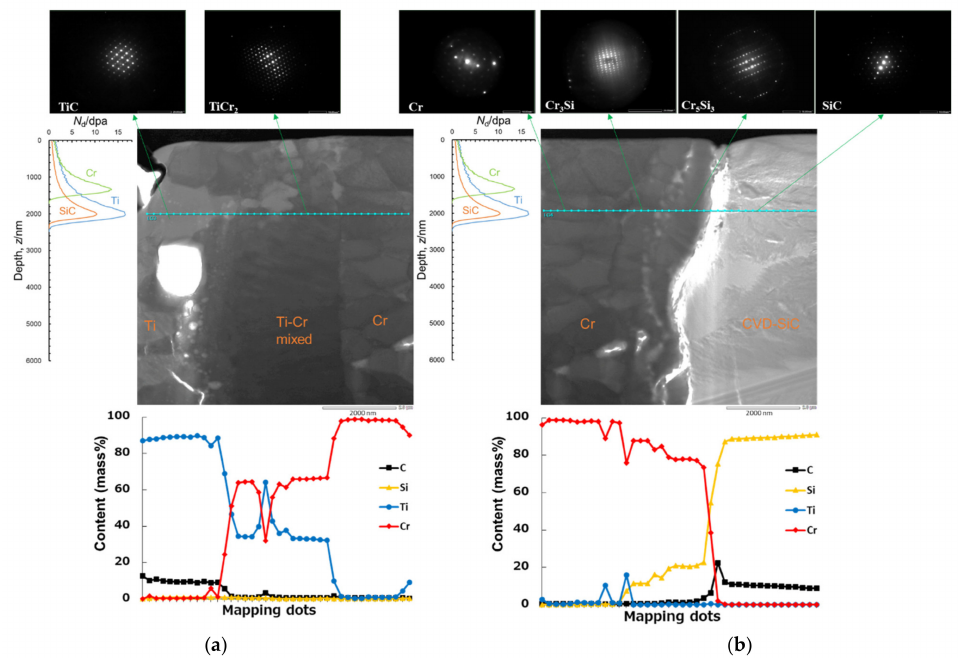
Figure 11. EDS line profiles of chemical composition and constituent phases along the analyzed line (bule-green) at the peak positions for the number of displacements per atom and constituent phases in Ti-Cr multilayer coating after being irradiated with Si 2+ ions up to a fluence of 2.85 × 10 20 ions /m 2 . The analyzed lines included ( a ) Ti, Ti-Cr mixed and Cr layers and ( b ) Ti-Cr mixed, Cr, diffused Cr-SiC interface, and CVD SiC layers.